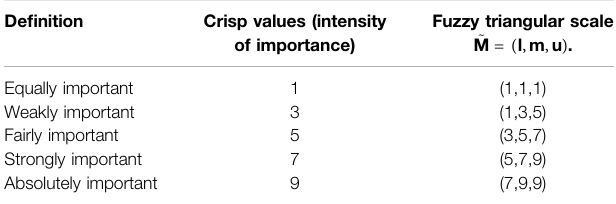
TABLE 2 | Mapping between fuzzy linguistic values, triangular-fuzzy and numeric scale. De fi nition Crisp values (intensity of